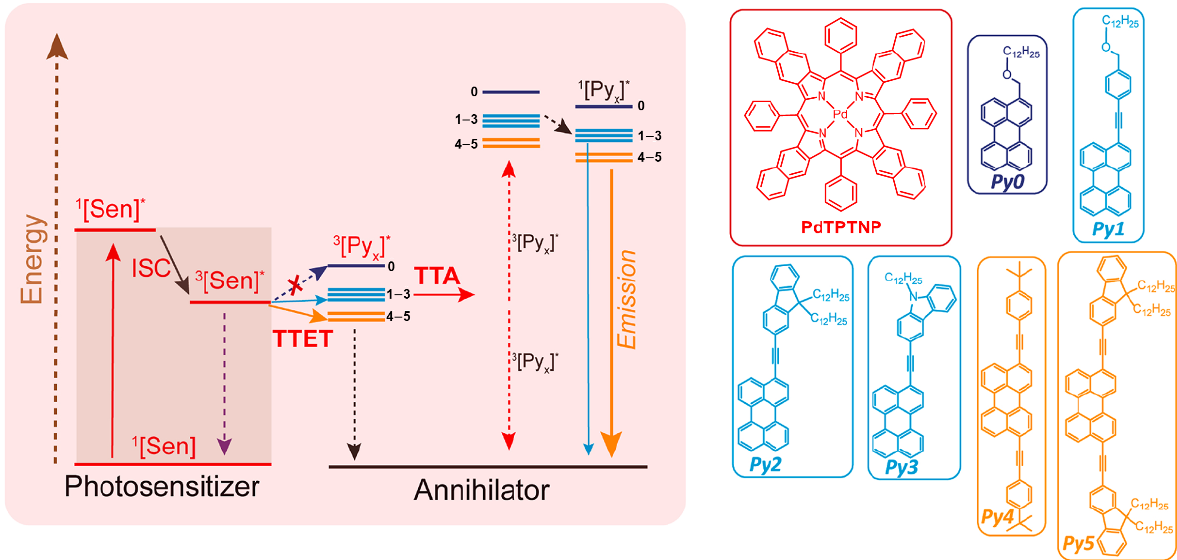
Figure 5. Schematic representation of the design for TTA-UC systems excited by NIR light via the optimization of annihilators (Py0 − Py5), in which the symbol * refers to the excited state. Reprinted with permission from ref. [87]. Copyright 2020 American Chemical Society.